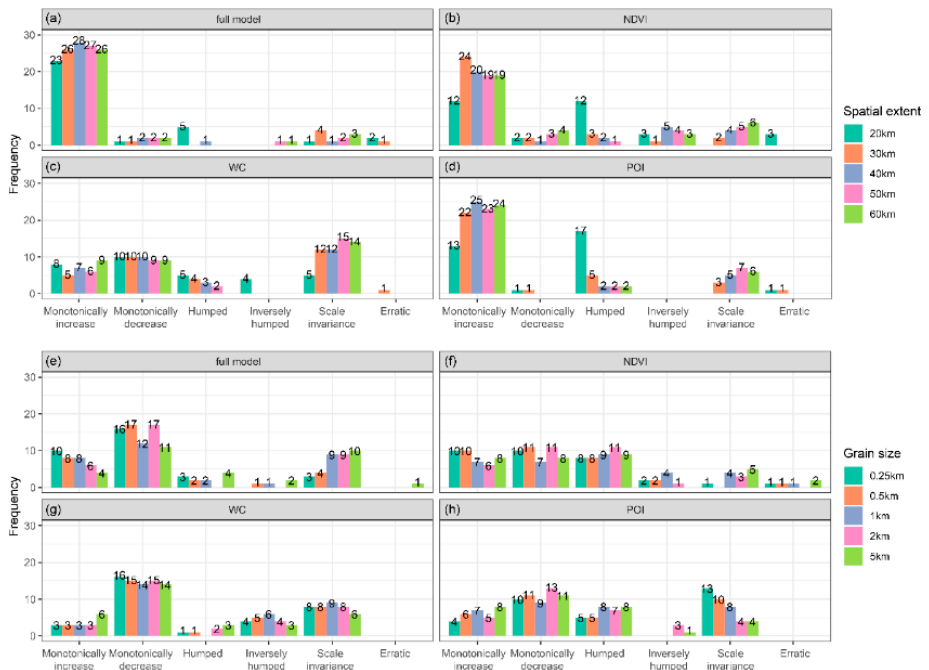
Figure 5. The frequency (number of cities) distributions of six types of scaling relations with respect to grain size (at each fixed spatial extent, a – d ) and spatial extent (at each fixed grain size, e – h ) for the individual explanatory power of NDVI, water cover (WC), and POI density as well as their overall explanatory power. The number of cities (the frequency) that had a specific scaling relation type is annotated above the corresponding bar.